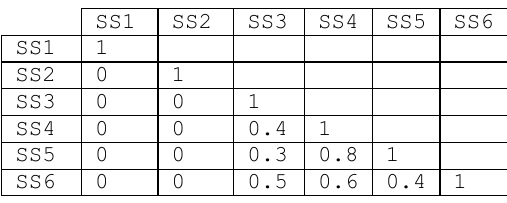
Figure 3. Matrix of similarity values used in the clustering